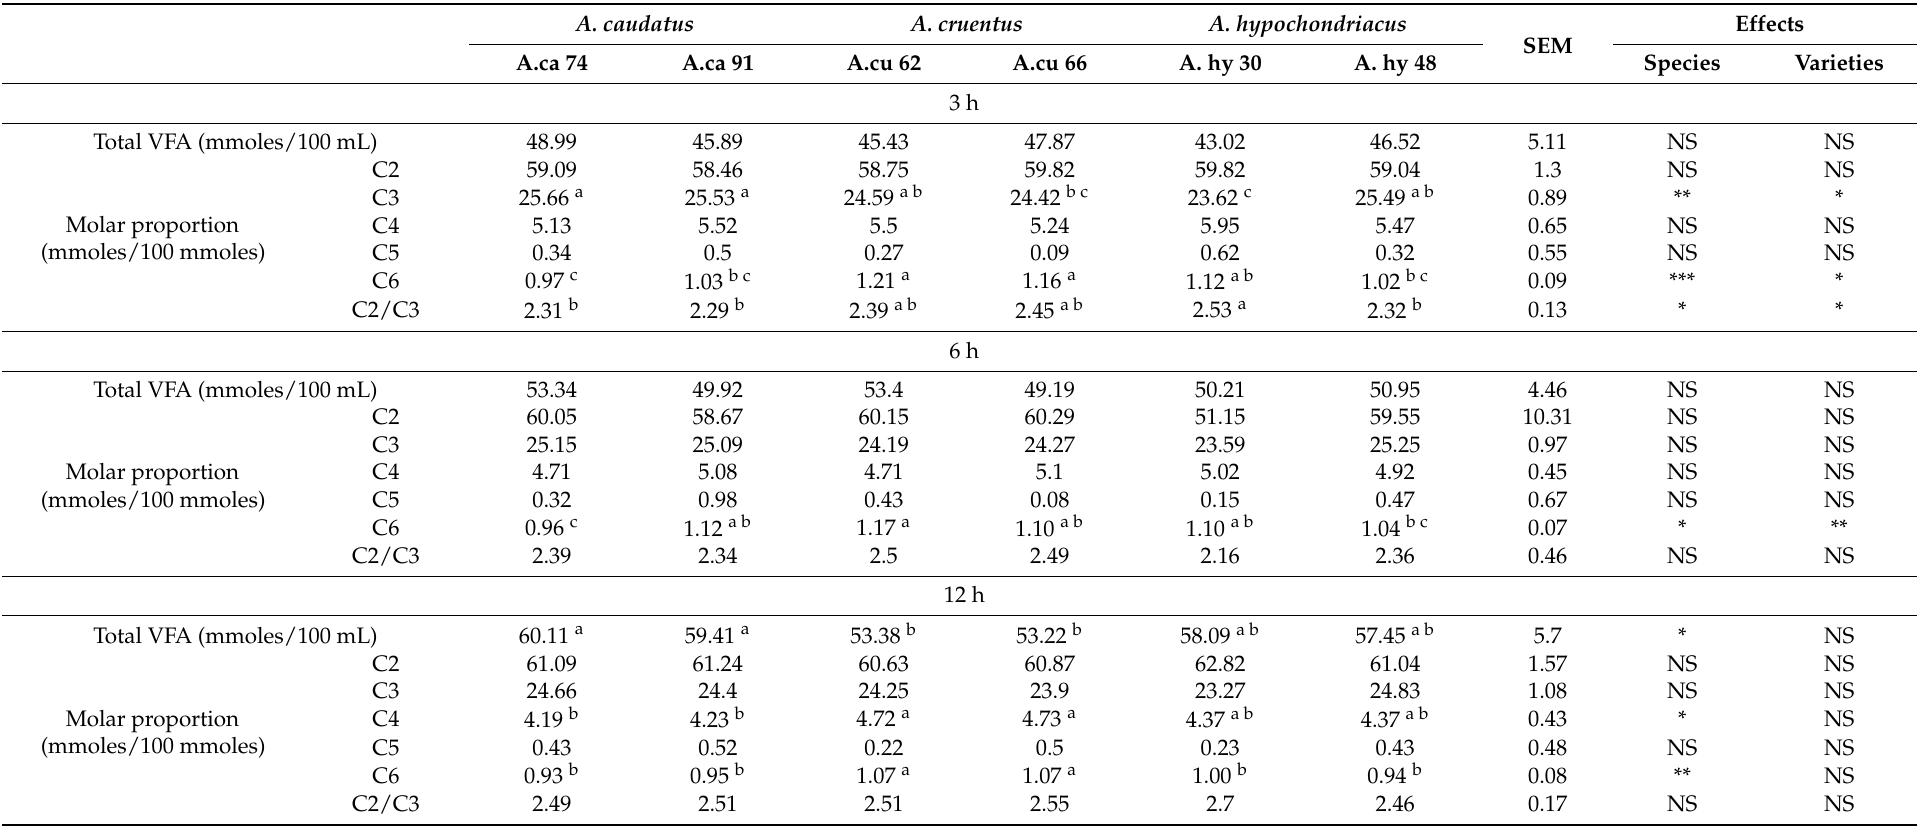
Table 3. Total volatile fatty acids (VFA) concentration and VFA molar proportions of different amaranth